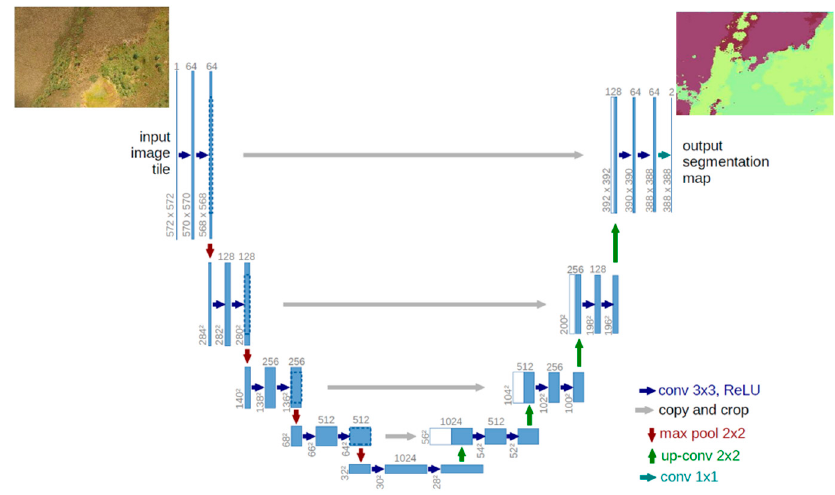
Figure 8. UNet architecture for semantic segmentation for bog-ecotope semantic segmentation.